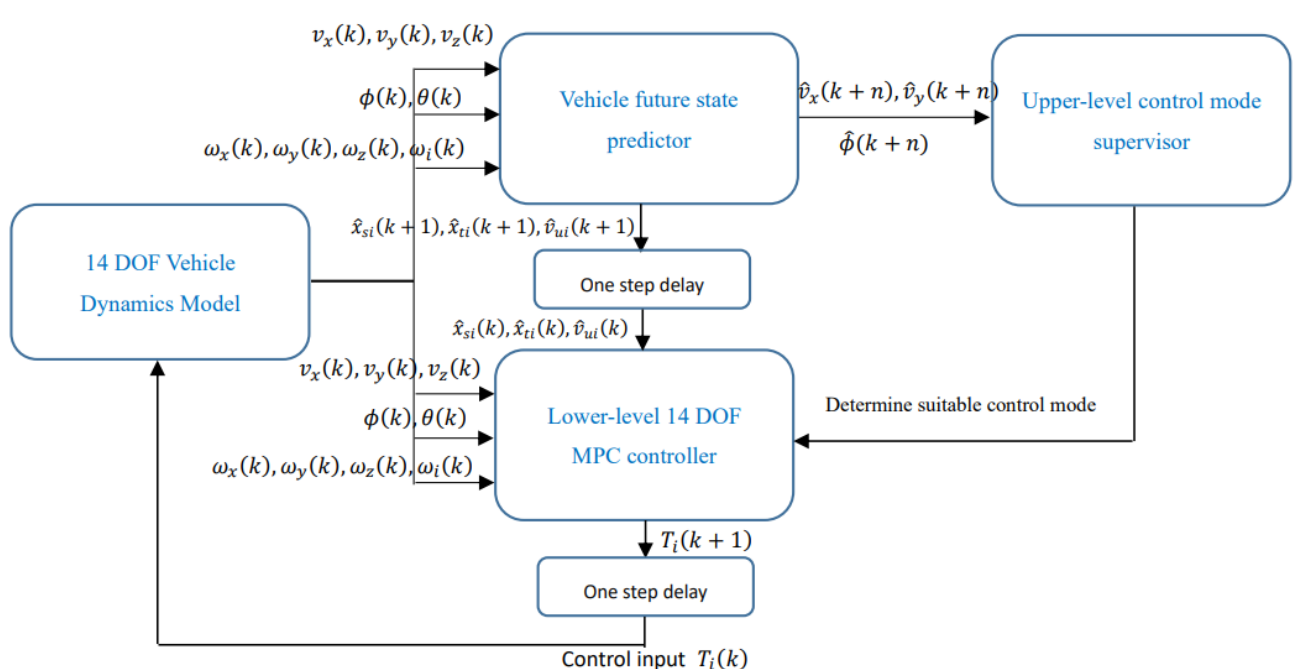
Figure 7. The structure diagram of proposed three-dimensional integrated stability control framework.